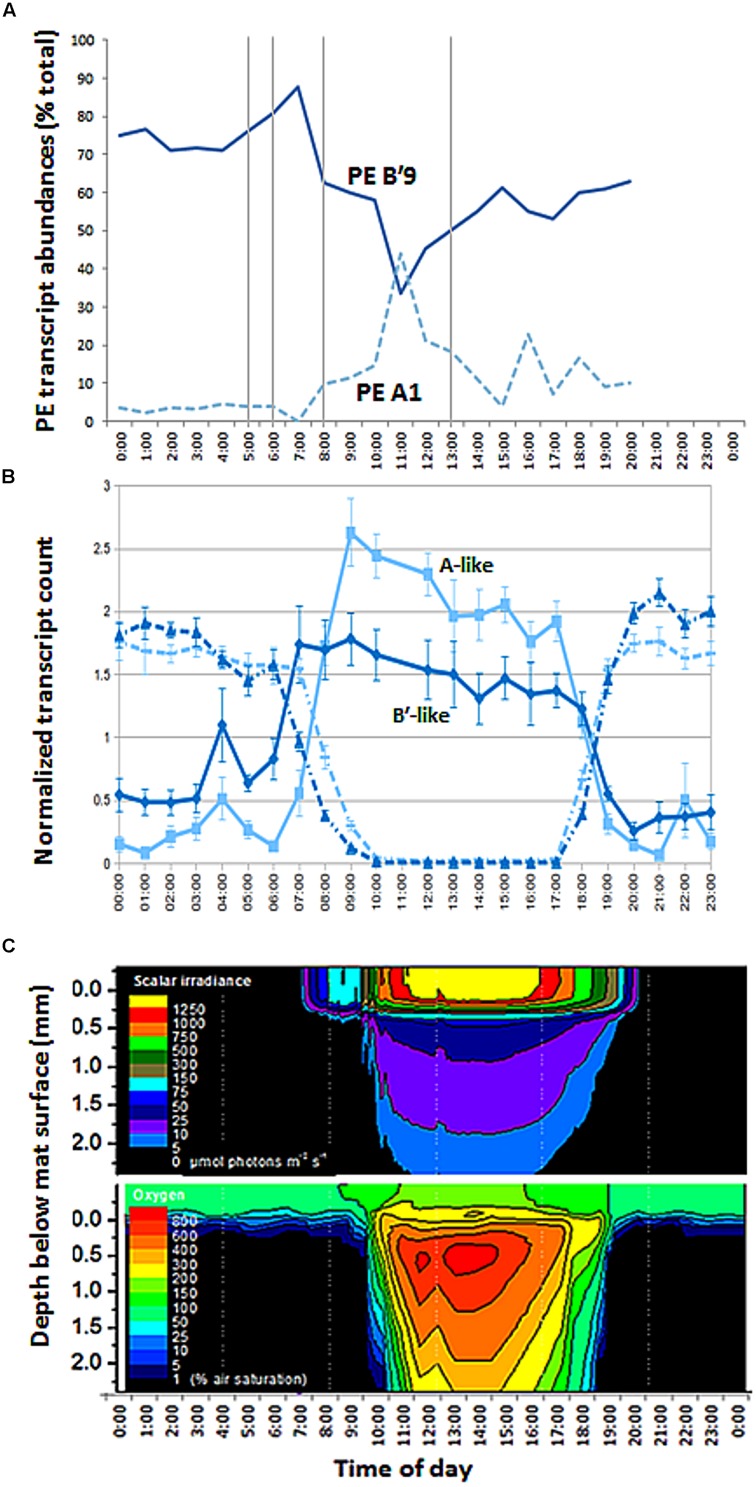
Diel transcription and change in irradiance and oxygen concentration with depth in 60°C Mushroom Spring mat. (A) Relative abundances of transcripts of abundant PEs B′9 and A1 measured from psaA cDNA over the diel cycle. Samples corresponding to time points at 0500, 0600, 0800, 1300 (vertical lines), 2100, 2200, and 2300 are missing due to failed sequencing reactions. (B) Normalized count of B′-like (dark blue) and A-like (light blue) combined photosystem (solid line) and nitrogen fixation (dashed line) transcripts over the diel cycle. (C) Isopleth diagrams showing depth distribution of scalar irradiance (μmol photons m-2 s-1) and O2 concentration (% air saturation) over the diel cycle. Samples at time points 1700, 1800, 1900, and 2000 h in part A were from the previous evening, 11 September 2009.